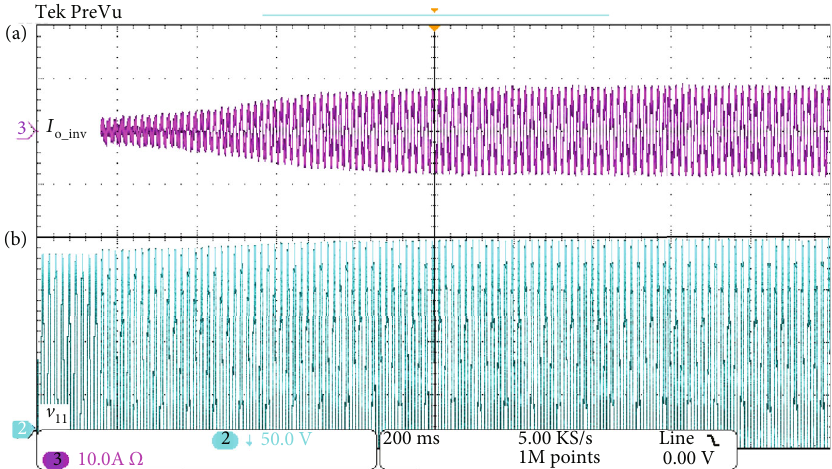
Figure 9: Startup: (a) current in residence 11 ( I